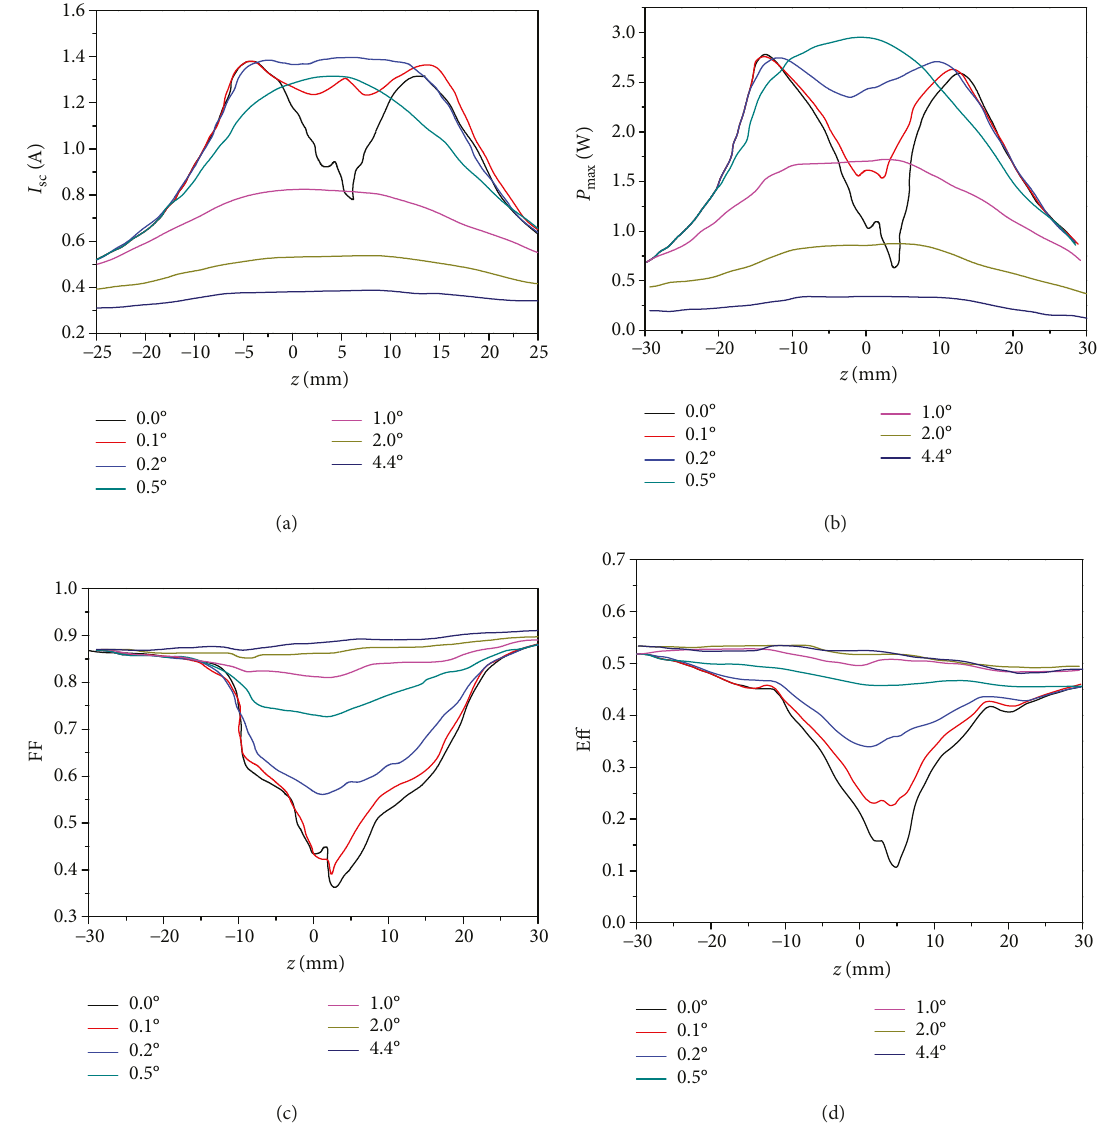
Figure 10: Variation of the cell characteristic parameters with the optical axis position under di ff erent divergence angles of light sources (cell size 5 mm ∗ 5mm): (a) short circuit current; (b) maximum-output power; (c) fi ll factor; (d) cell e ffi ciency.